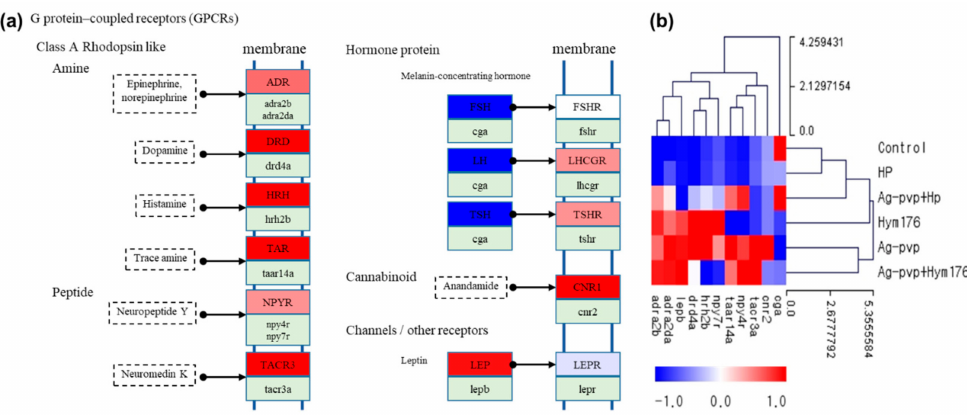
Figure 4. ( a ) E ff ects of N-Ag-PVP exposure on G-protein-coupled receptor (GPCR) gene expression in zebrafish larvae and ( b ) heatmap of GPCRs by z-score. N-Ag-PVP stimulated up-regulation of several GPCR genes. The z-score is based on the average of each expressed gene.